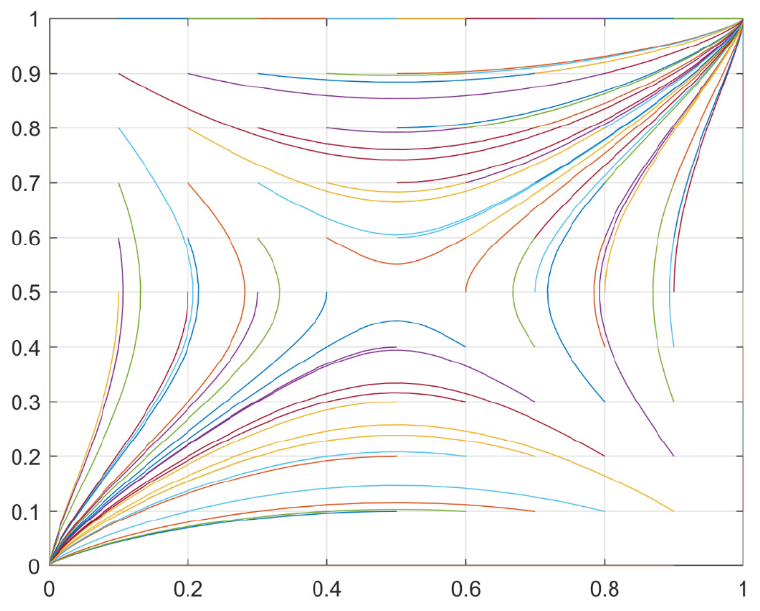
Figure 5. Dynamic evolution phase diagram for construction enterprises 1 and 2 in case (2) and (4).